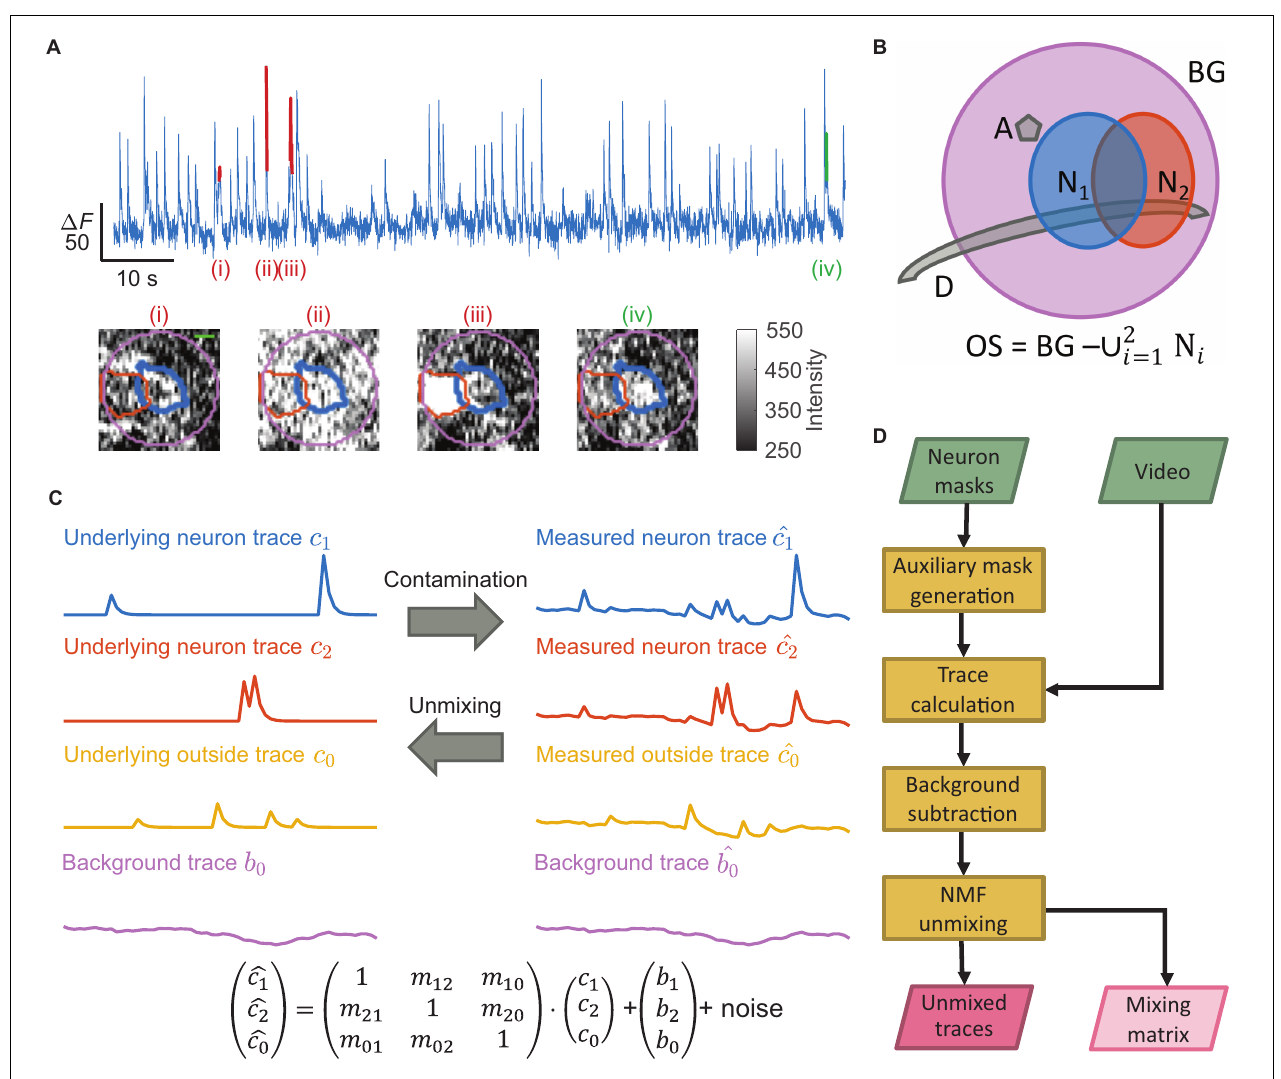
FIGURE 1 | Neural signal contamination arises from neighboring cells, neural processes, or background. (A) An example temporal trace from one neuron showed multiple false transients. Four labeled transients (i)–(iv) show four examples with different origins, corresponding to the images below the trace. Each image is the corresponding spatial profile of fluorescence at the peak of each labeled transient. The colored contours in each image show the boundary of the segmented neuron (thick blue), the boundary of a neighboring neuron (orange), and the background region (purple) surrounding the segmented neuron (scale bar: 5 µ m). Only transient (iv) was a true transient of the neuron (green), where the spatial profile of activation matched the neuron shape. The remaining transients were false transients (red) caused by contamination with spatial profiles not matching the neuron shape. Transient (i) came from a dendrite, transient (ii) came from background fluctuation, and transient (iii) came from an active neighboring neuron. (B) A schematic shows multiple typical contaminating sources around the neuron of interest (N 1 ; blue); we show a neighboring neuron (N 2 ; orange), an axon perpendicular to the imaging plane (A; gray), and a dendrite in the imaging plane (D; gray). In practice, multiple instances of each type of contaminating source may exist. The purple disk is the background region (BG) near the neuron. We defined the outside region (OS) as all pixels within the background region but not belonging to any neuron mask. (C) Matrix multiplication can represent the fluorescence contamination between regions. The mixture of the uncontaminated neuron traces ( c 1 and c 2 ), the outside trace ( c 0 ), and the background trace ( b 0 ) generated the measured traces c 1 , c 2 , and c 0 . This work produced the uncontaminated traces from the measured traces. (D) A flow chart of our unmixing algorithm, TUnCaT. The inputs are the video and the neuron masks, and the outputs are the unmixed traces and the mixing